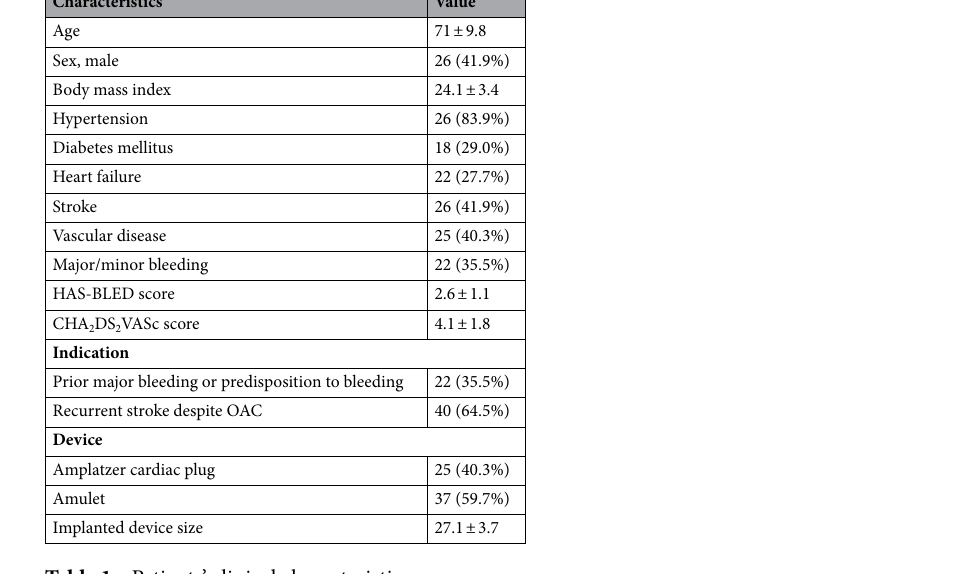
Table 1. Patients’ clinical characteristics.